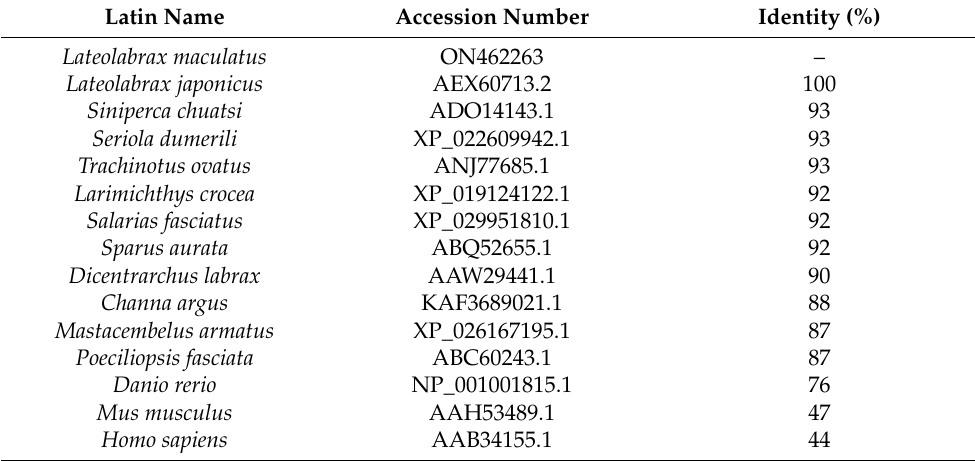
Table 3. Fourteen SNP alleles and genotype frequency of igf2.